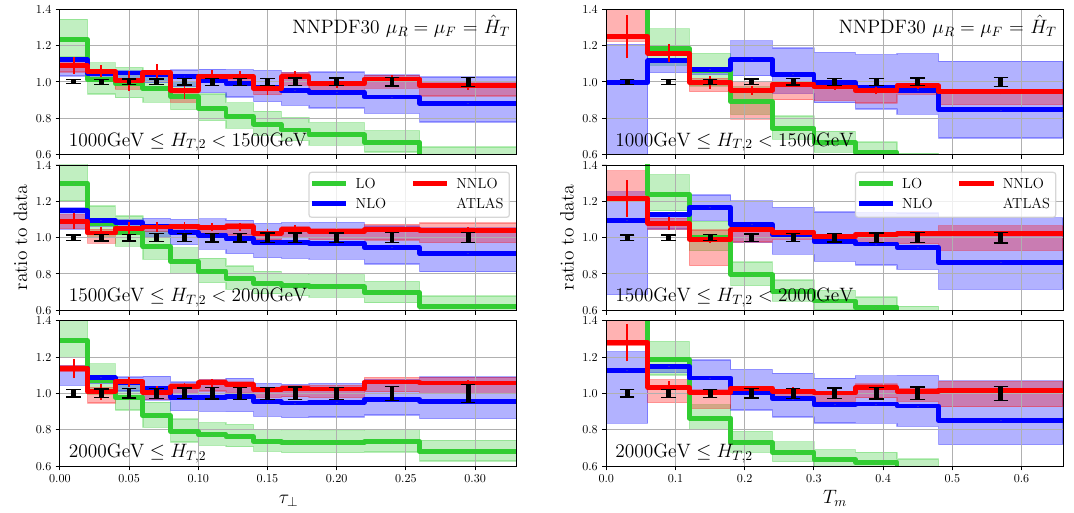
Figure 1 . The transverse thrust τ ⊥ (left) and the thrust minor T m (right) in three H T, 2 bins. The solid lines show fixed order LO (green), NLO (blue), and NNLO (red) predictions normalised to ATLAS data (black) [17]. The coloured bands show the scale